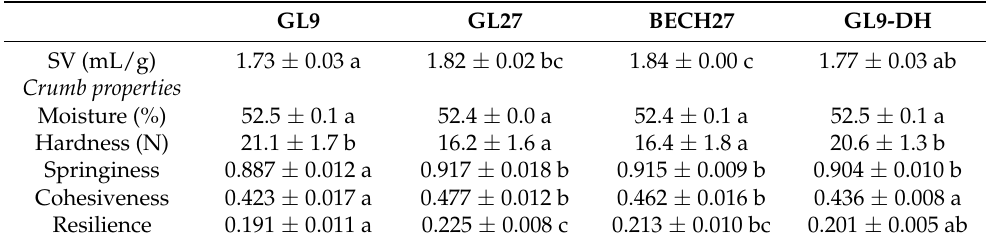
Table 4. Specific volume (SV) and crumb properties of the CRCs based